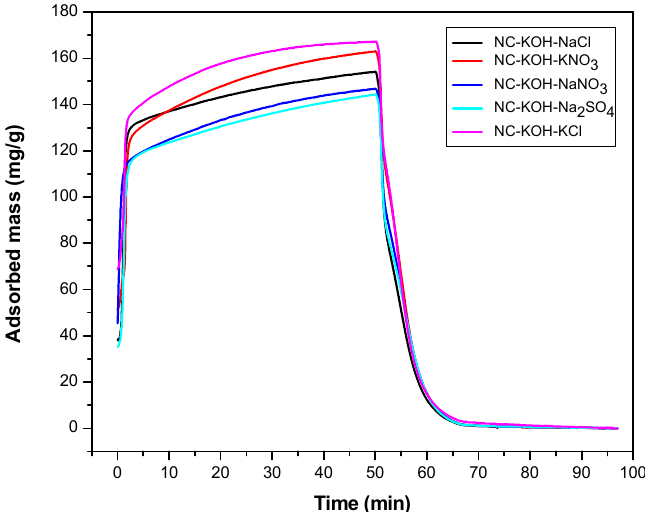
Figure 3. TG curves measured CO 2 adsorption and desorption of samples activated by different salts.